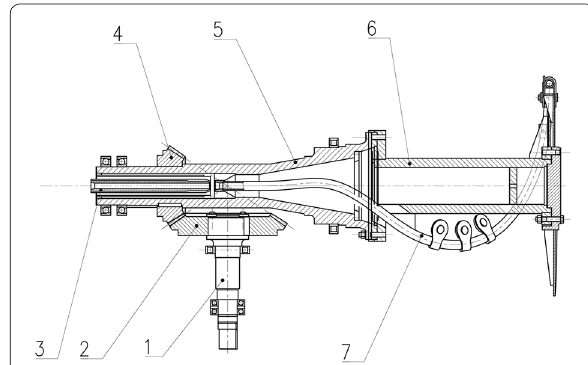
Figure 3 A design scheme of laying head machine